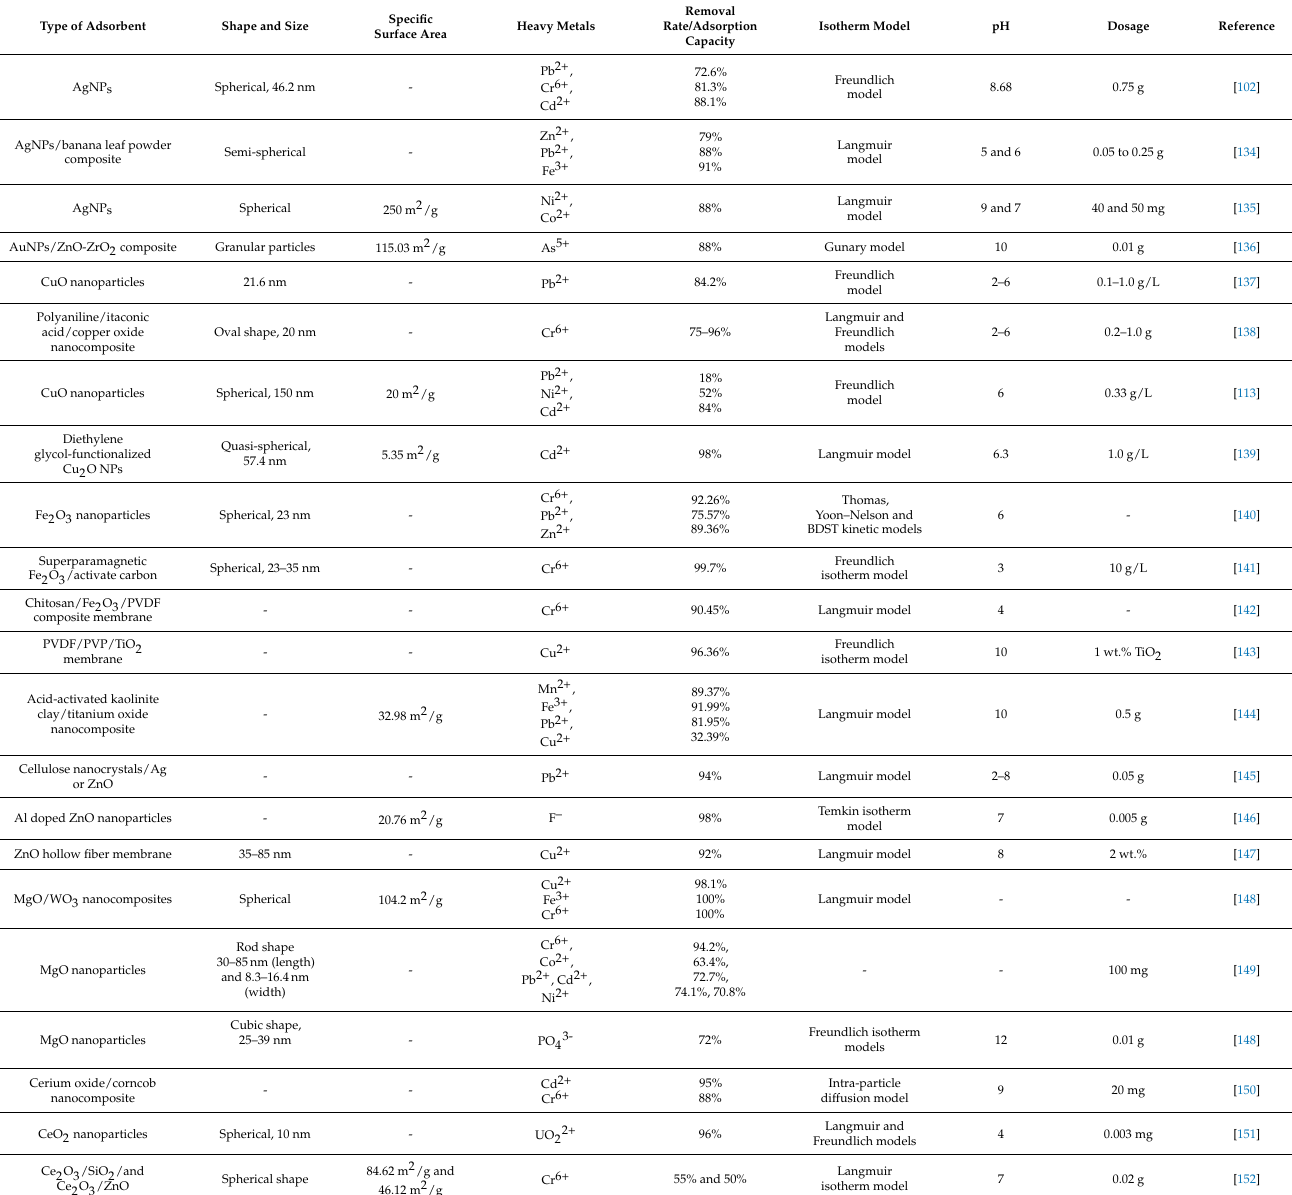
Table 2. Nanomaterials for heavy metal